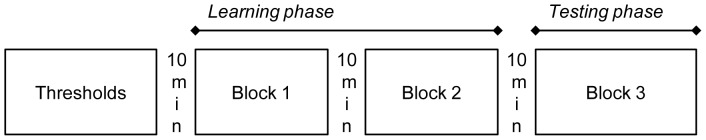
Flow diagram showing the experimental procedures of the study in chronological order.